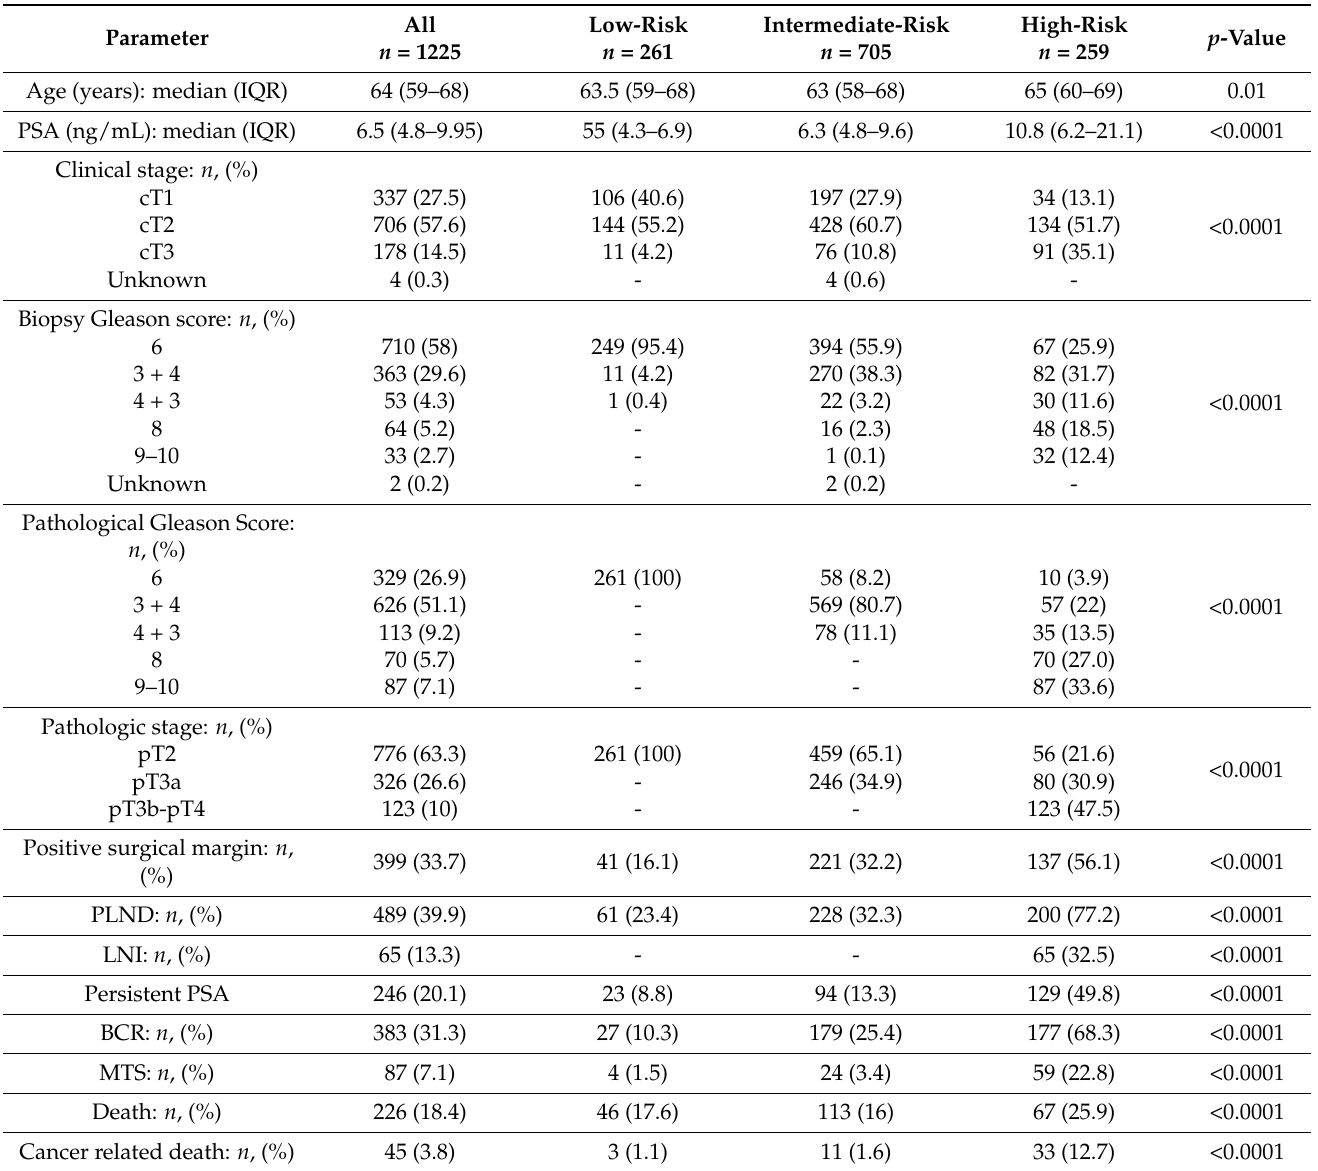
Table 1. Patient